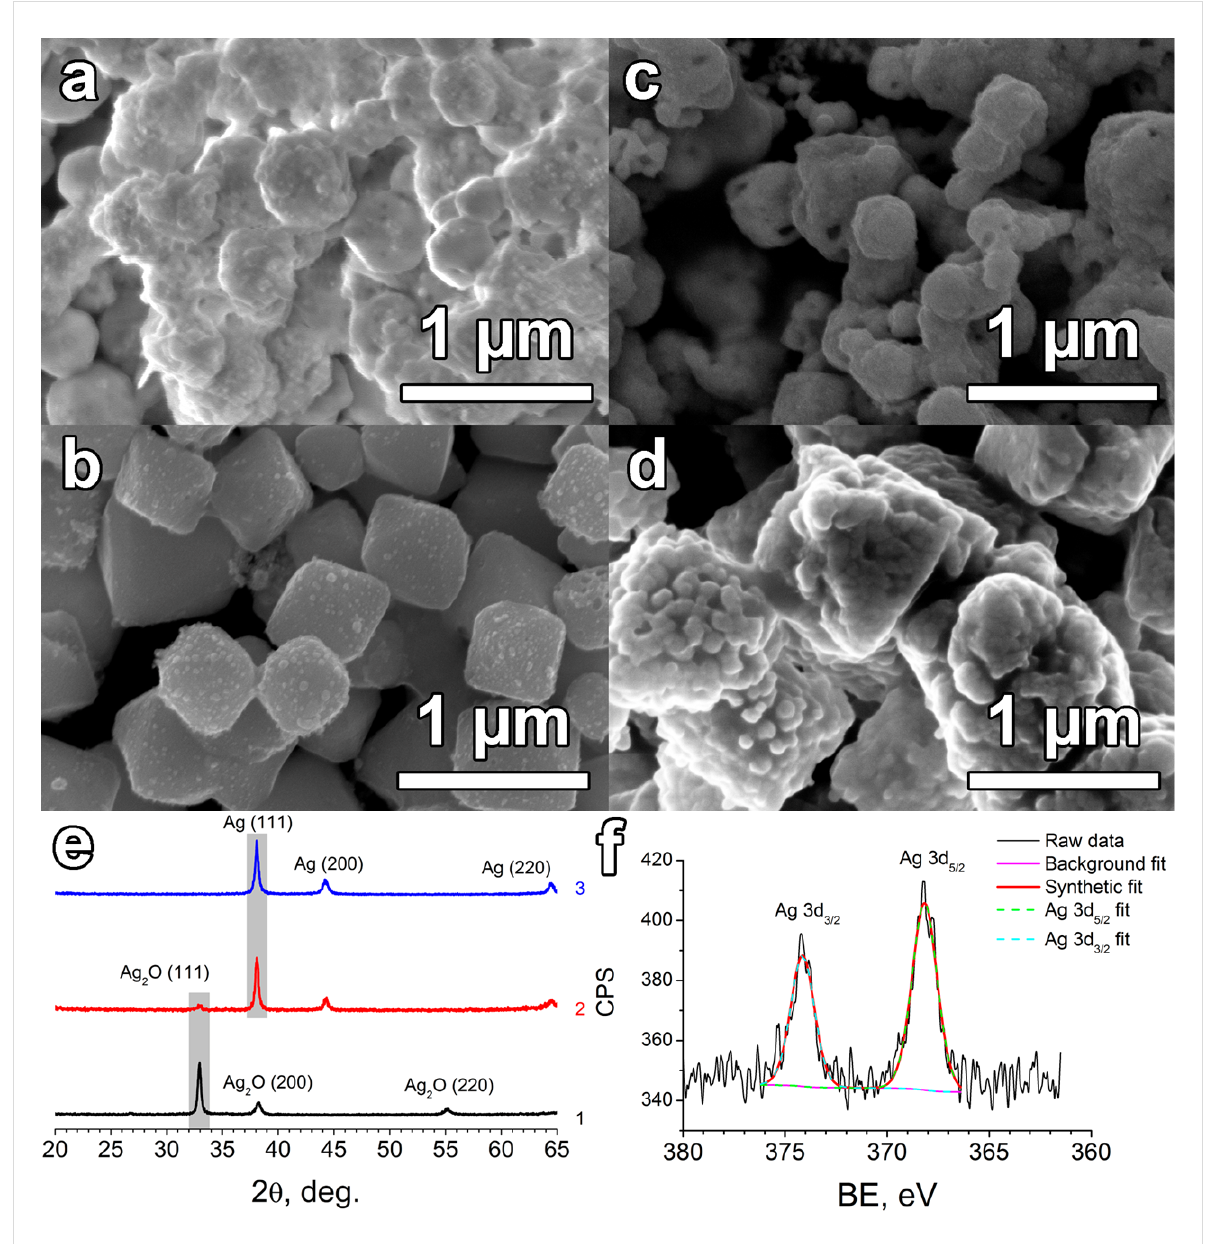
Figure 1: (a,b) SEM micrographs of Ag 2 O crystallites produced by alkaline sedimentation in excess of PVP, namely, (a) AgNO 3 /PVP 1:10 and (b) AgNO 3 /PVP 1:5. (c,d) SEM micrographs of the samples obtained by Ag 2 O reduction using NaBH 4 with the following molar ratios: (c) Ag 2 O/NaBH 4 1:2 and (d) Ag 2 O/NaBH 4 1:10. The reducing treatment time was 40 min for both the samples. (e) XRD data for pristine Ag 2 O (1) and reduction products at double excess of NaBH 4 (2) and ten-fold excess of NaBH 4 (3). (f) XPS spectra of silver mesoporous particles (mp-Ag) obtained in a Ag 2 O/NaBH 4 1:10